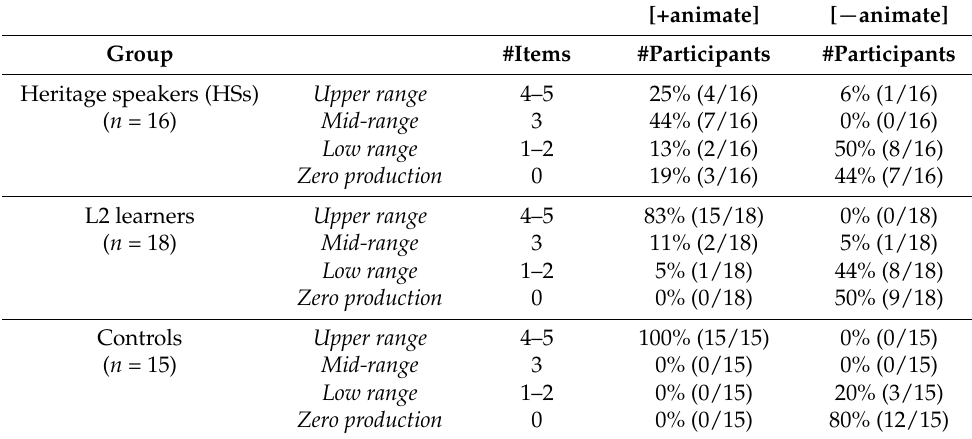
Table 2. EPT: proportion of overt DOM use in simple sentences.